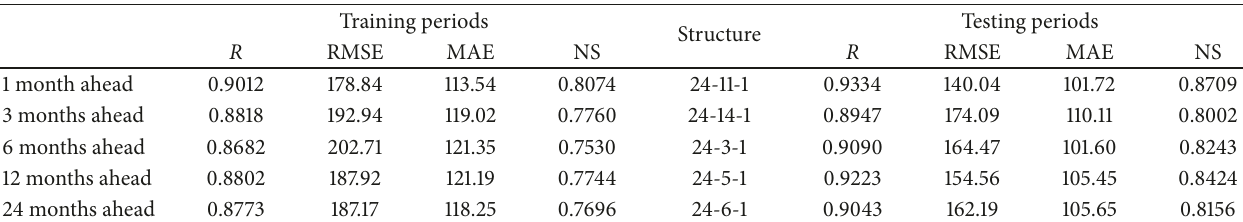
Table 8: Performance of the ANN model with two input variables (precipitation and air temperature) during the training and testing periods for 1-, 3-, 6-, 12-, and 24-month-ahead runoff forecasting in the LARHR. Training